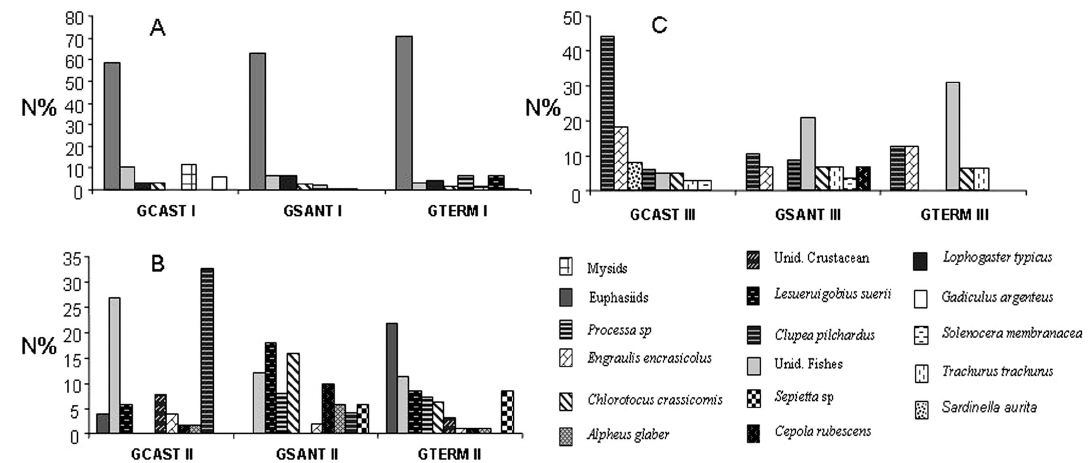
Fig. 3. – Per cent abundance (N%) of main prey items in the stomach contents of hake for the three classes in the three gulfs. GCAST, Gulf of Castellammare; GTERM, Gulf of Termini Imerese; GSANT, Gulf of Sant’Agata; I, size class I (60-120 mm TL); II, size class II (121-220 mm TL); III, size class III (221-410 mm